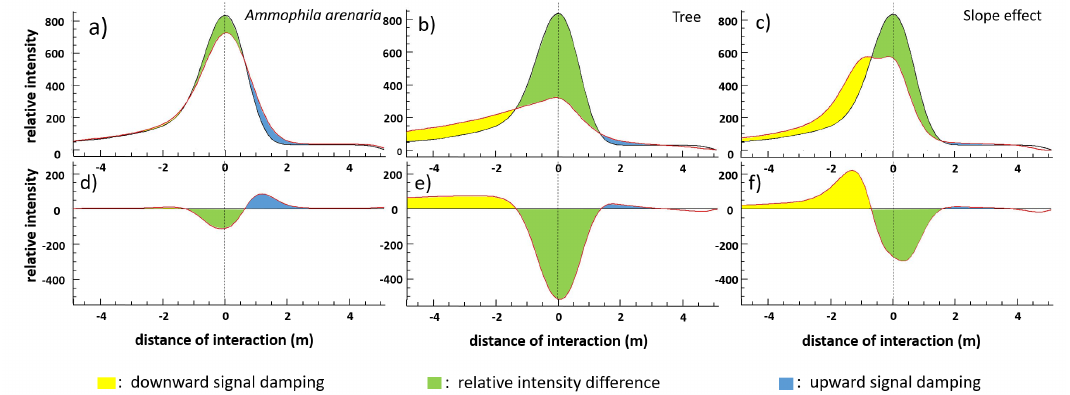
Figure 7. Shape analysis methodology. ( a – c ) represent the dNCCFWF signal, whereas ( d – f ) represent the deviation from the dry sandy surface reference used for surface identification, as it emphasizes the shape variations. The black curve represents the dry sandy reference signal and the red curve represents the signal of the considered object ( Ammophila arenaria for ( a , d ), tree for ( b , e ), and slope effect for ( c , f )). The colors represent the main shape variation of the considered signal from the dry sand reference: blue is the upward damping, corresponding to the FWF marram index measured area, yellow is the downward damping, corresponding to the FWF down index, and green is the relative intensity difference at the position of the center of the